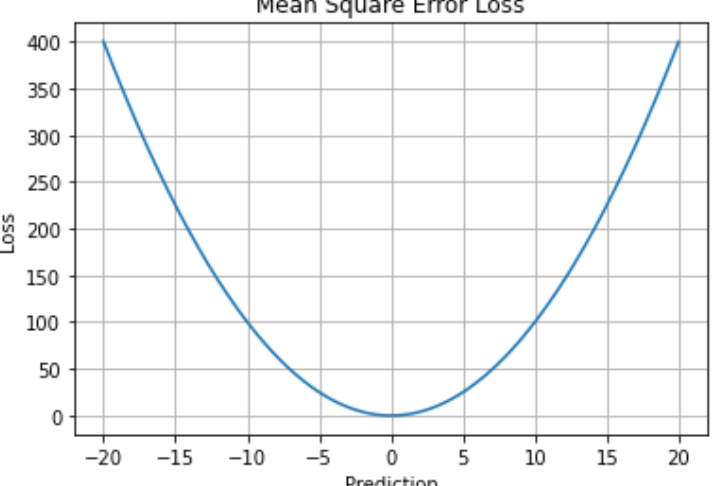
Figure 3. Mean Squared Error (MSE)—MR.